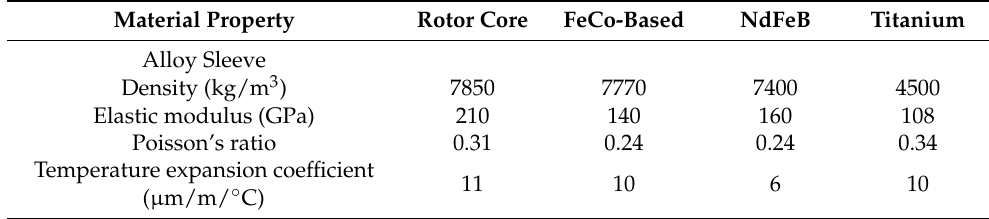
Table 1. Rotor material performance